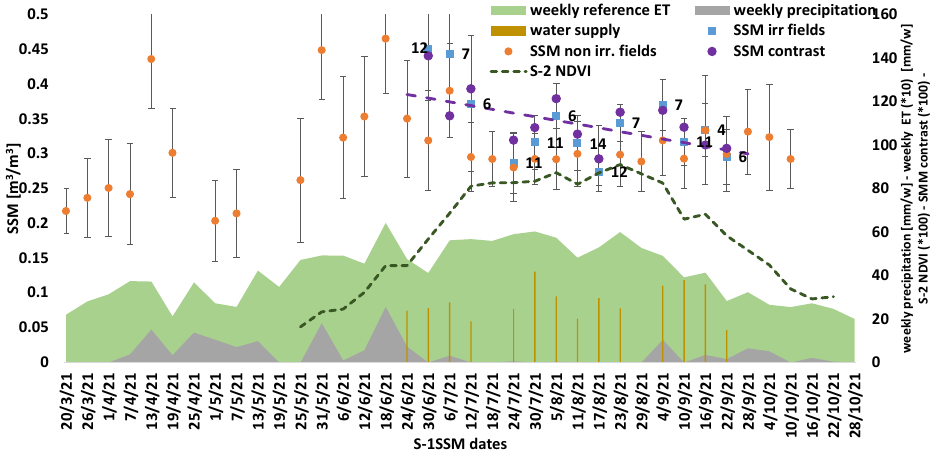
Figure 12. Temporal behavior of average SSM of maize irrigated (blue squares) within 1 day before the S-1 passages and non-irrigated wheat/barley (orange circles) fields in 2021. Bars refer to the inter-field variability. The number of maize fields irrigated is in black. Time series of SSM contrast (purple circles scaled by 100) and their linear fit (purple dashed line) are on the secondary axis. Weekly precipitation and reference evapotranspiration (ET) rate (scaled by 10) are reported in gray and green shaded areas on the secondary axis, too, as well as the S-2 NDVI (dashed green line, scaled by 100).